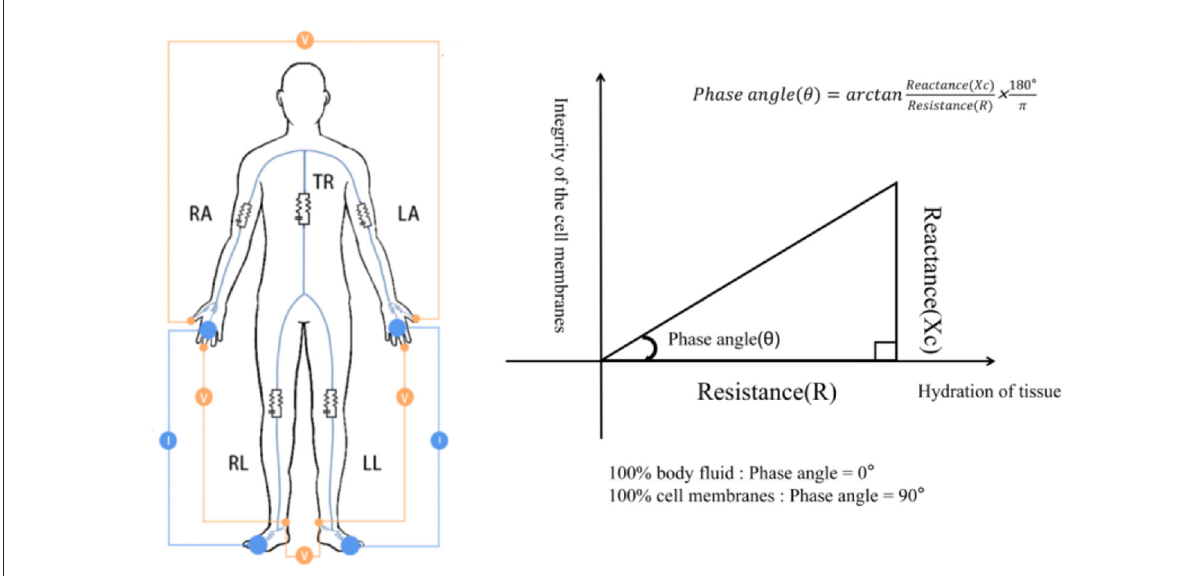
FIGURE1 Diagram showing how PhA is measured. RA, right arm; LA, left arm; TR, trunk; RL, right leg; LL, left leg. The resistance and reactance to the voltage generated by the device is